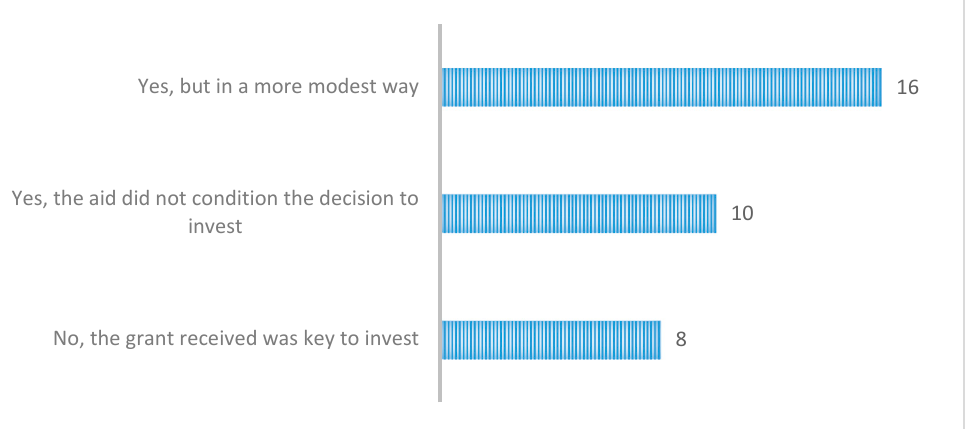
Figure 2. Would you have approached your project without Proder help? Source: Own elaboration . Land 2020 , 9 , x FOR PEER REVIEW